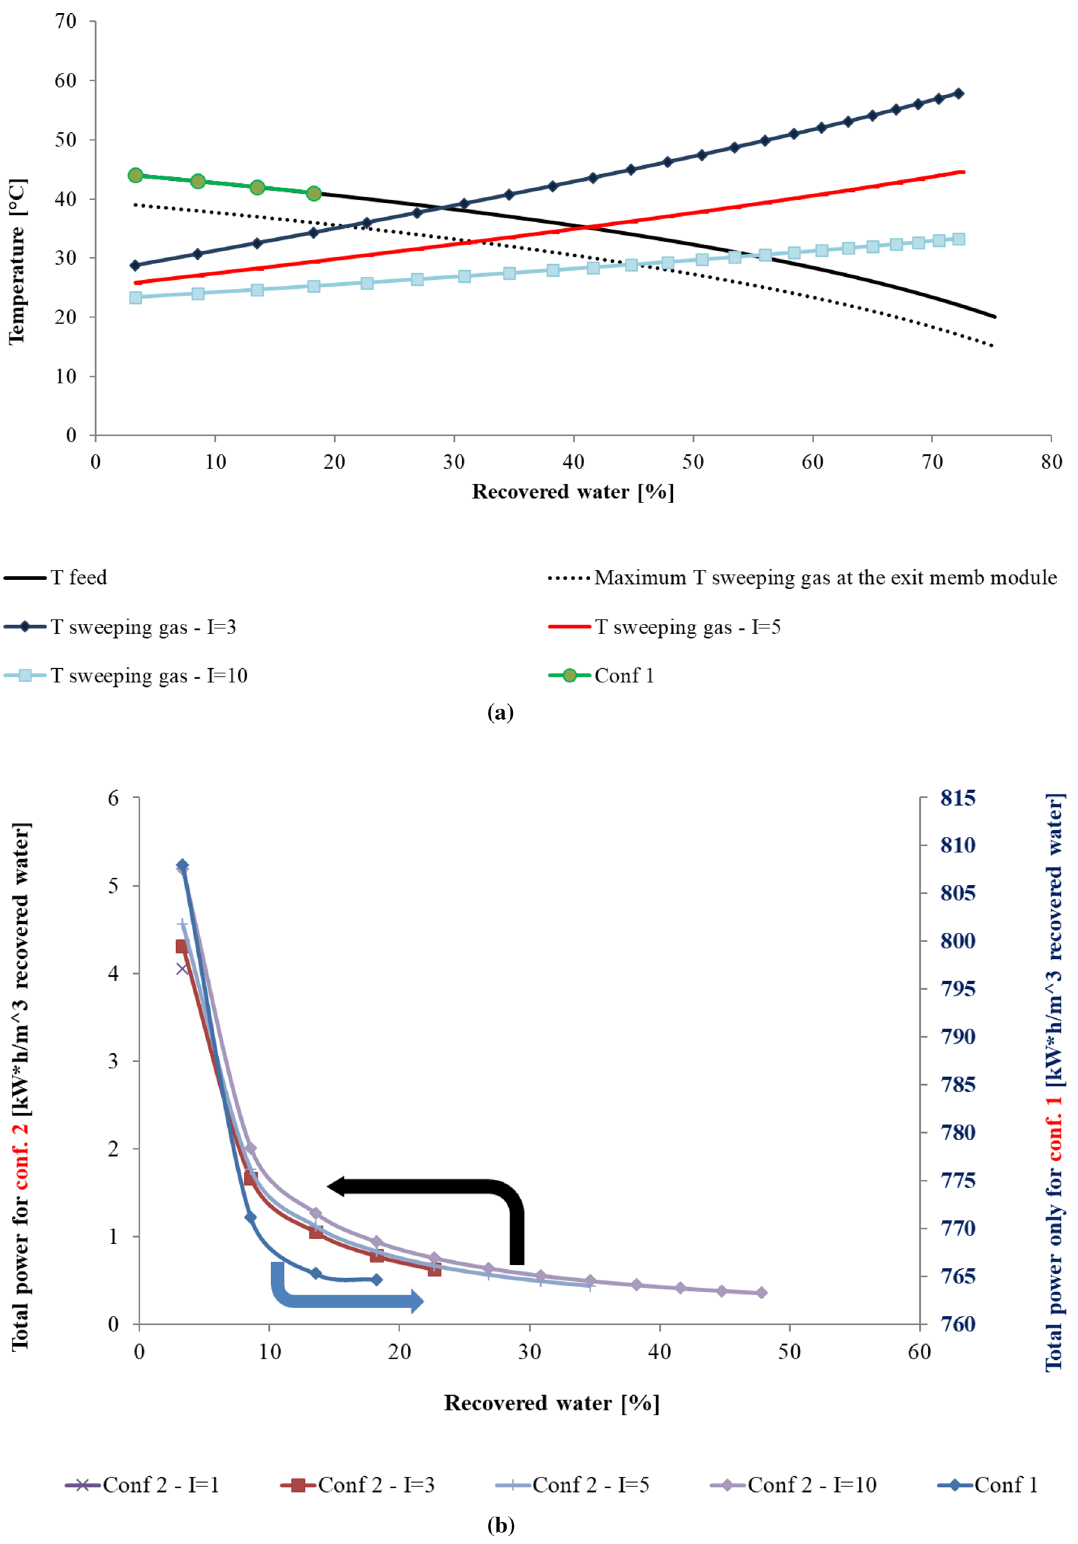
Fig. 7 Comparison of temperature and energy consumption for configuration 1 and 2. Feed temperature = 45 °C; RH feed =